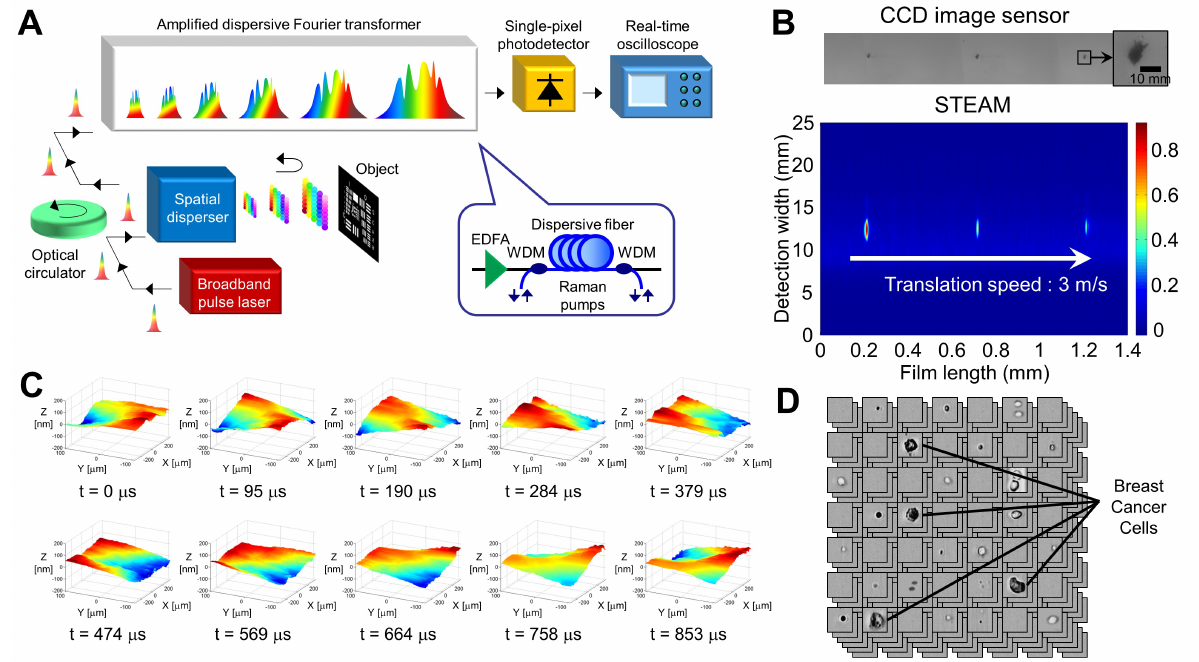
Fig. 4. STEAM. (A) Schematic. (B) Surface inspection with STEAM. (C) Surface vibrometry with STEAM. (D) Cancer detection with STEAM. ©Figure courtesy of Ref. [23, 24, 26,